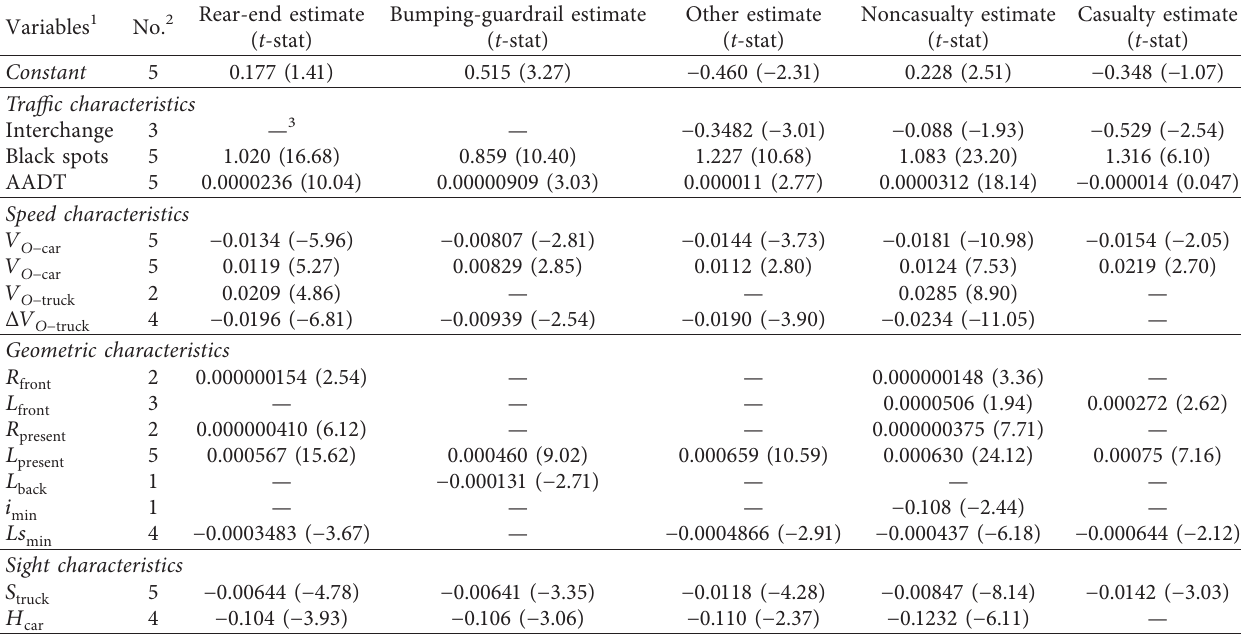
Table 8: Independent Poisson model estimation